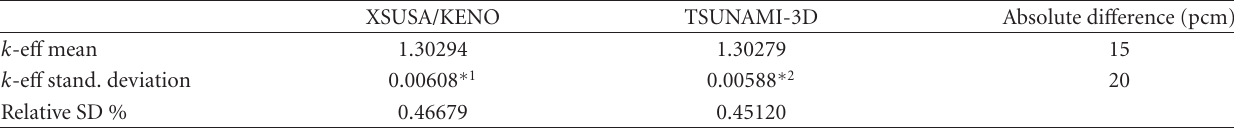
Table 3: Uncertainty in the e ff ective multiplication factor from using “one-step”